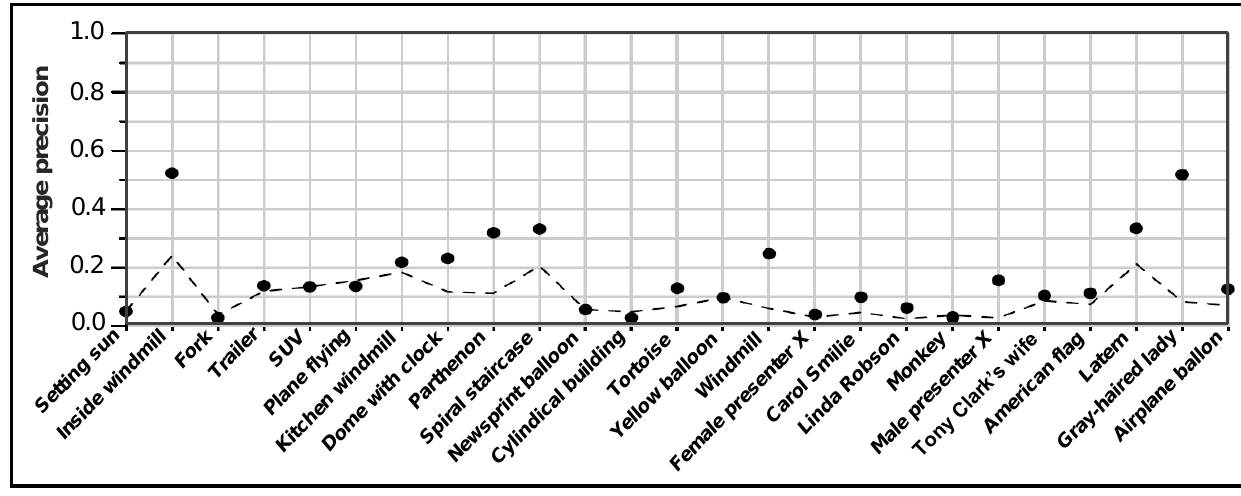
Figure 14. Evaluation results for each query.